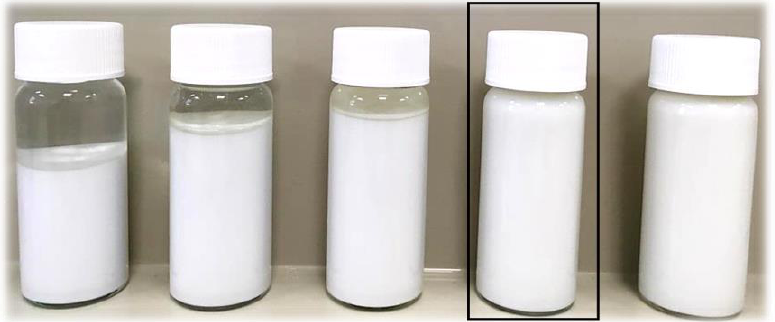
Figure 3. The HAp suspensions in PVP solutions directly after the study (from left: 0%, 5%, 10%, 15% and 20% PVP).